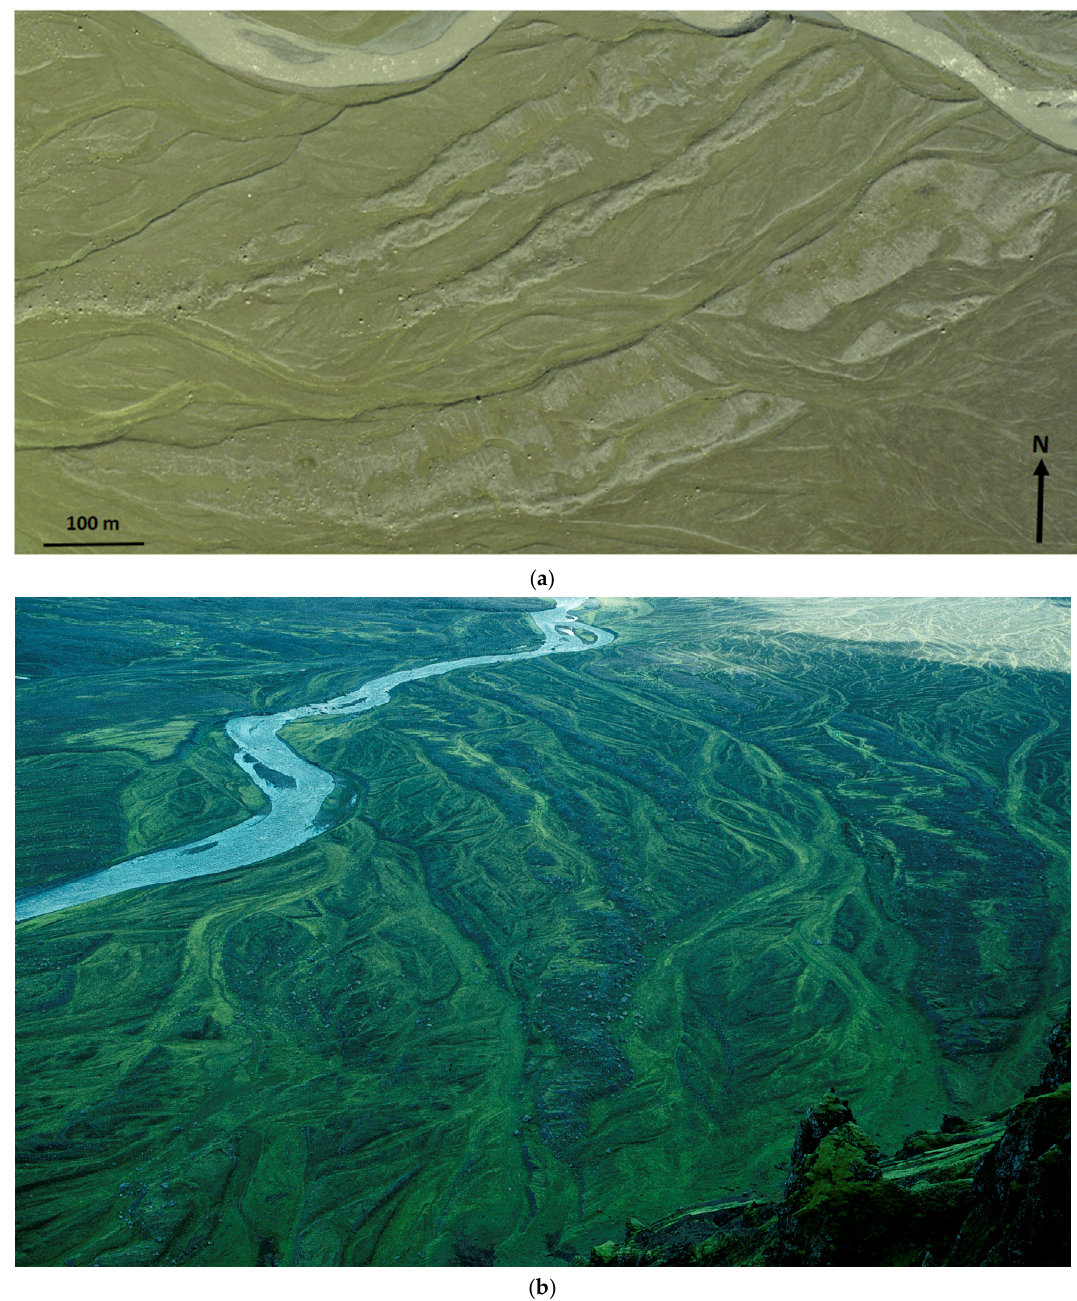
Figure 12. Glacifluvial deposits in narrow ribbons of terraced outwash infilling channels between arcuate overridden moraine ridges and push moraines on the Sandfellsjökull foreland; ( a ) Aerial photograph extract (NERC ARSF 2007; former ice flow from the northwest); and, ( b ) View from the summit of Sandfell, showing the isolation of elongate “islands” of till and moraine (former ice flow from the left).